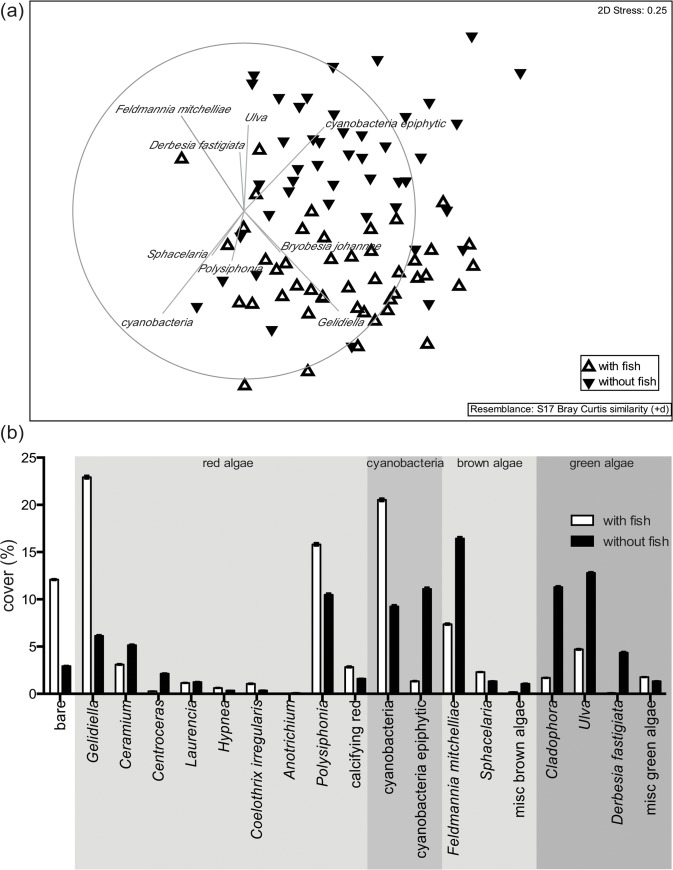
Turf algal species composition.The turf algal species composition in the presence and absence of farming damselfish at the end of the experimental period. (a) Two dimensional MDS plot on the basis of the Bray Curtis similarity with a vector overlay based on a 0.3 Spearman correlation. Only species occurring more than once were included (data were not transformed, plus dummy variable). (b) Percent cover of turf algal genera and groups (misc = miscellaneous). White triangles or bars = presence of damselfish farming, black triangles or bars = absence of damselfish farming for the duration of the experiment, n = 45 for each of the 2 herbivory treatments as data was pooled across CO2 emission scenarios.